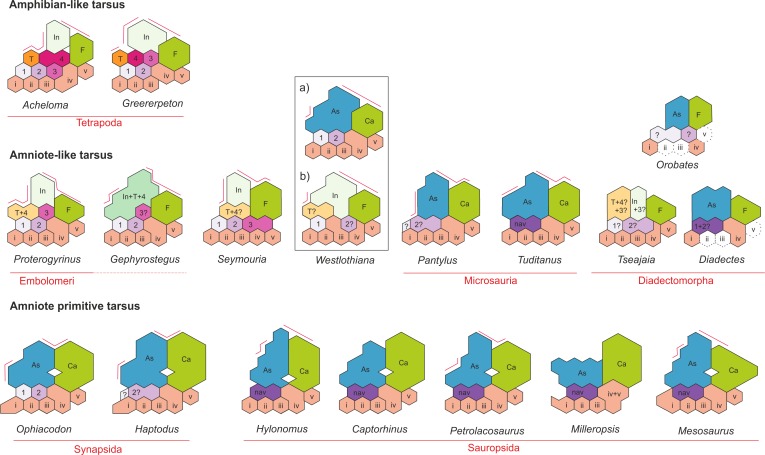
Tarsus structure in basal tetrapods, including amniote and non-amniote taxa.Schematic diagram for comparing the tarsus structure in the basal tetrapods Acheloma and Greererpeton (amphibian-like tarsus) with regard to that of embolomeres and microsaurs (amniote-like tarsus) and early amniotes. Note the similar structure and construction of the microsaur tarsus with respect to the early amniote Hylonomus. See text for more details of the evolutive significance of the selected taxa. Abbreviations: as, astragalus; i, intermedium; te, tibiale; 1, 2, 3, 4, centralia; i, ii, iii, iv, v, distal tarsals. Taxa were redrawn from the following sources: Acheloma (Dilkes, 2015); Greererpeton (Godfrey, 1989); Proterogyrinus (Holmes, 1984); Gephyrostegus (Carroll, 1970); Seymouria (Berman et al., 2000); Westlothiana (Smithson, 1989; Smithson et al., 1994); Pantylus (Carroll, 1968); Tuditanus (Carroll, 1968); Diadectomorphs (Moss, 1972; Berman & Henrici, 2003); Ophiacodon and Haptodus (Romer & Price, 1940); Hylonomus (Carroll, 1964); Captorhinus (Fox & Bowman, 1966); Petrolacosaurus (Peabody, 1952; Reisz, 1981).